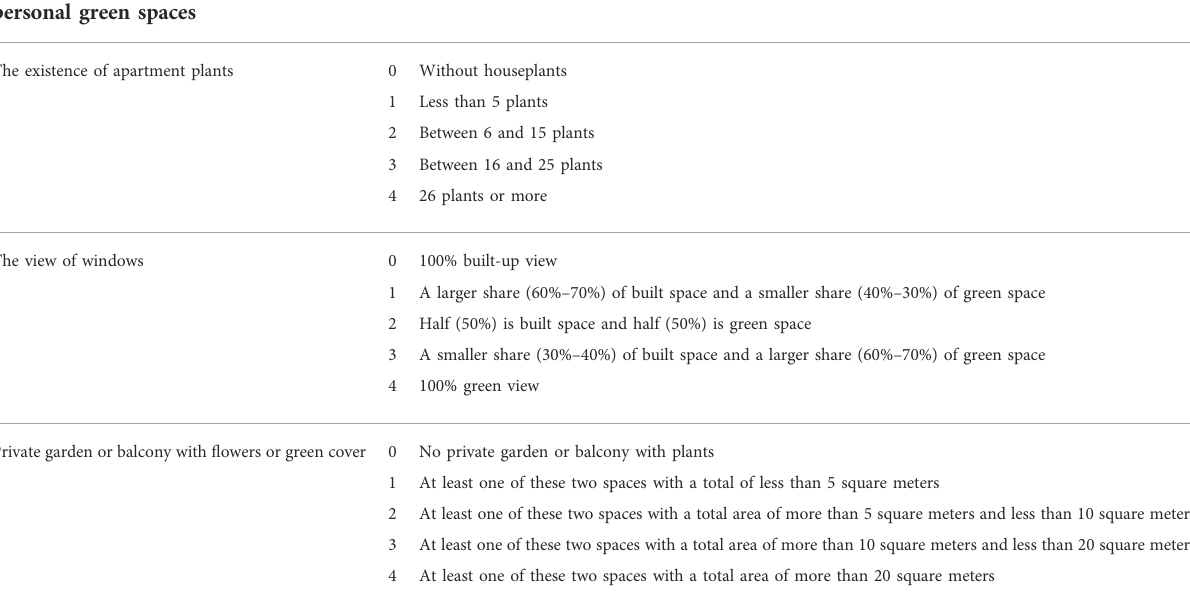
TABLE 1 Scale range of personal green space components.